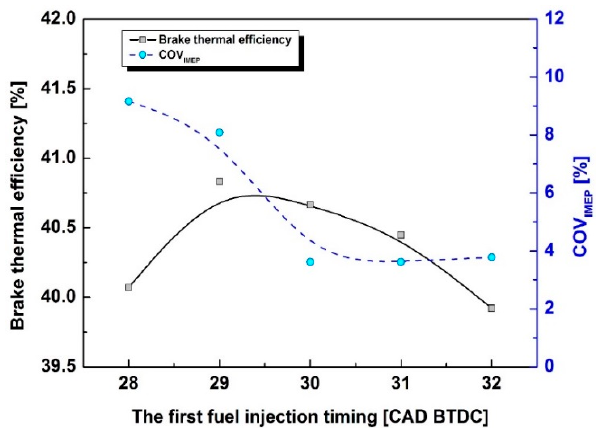
Figure 4. Variations in brake thermal efficiency and combustion stability according to the change in the first fuel injection timing with fuel injection ratio of 50%/50% and fixed second fuel injection and SA timing at 1600 rpm and BMEP of 0.24 MPa.